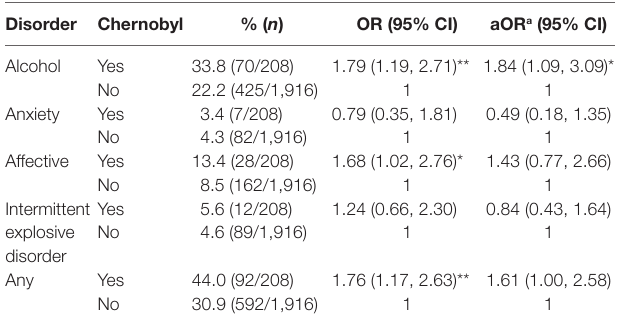
TaBle 3 | Male prevalence model.